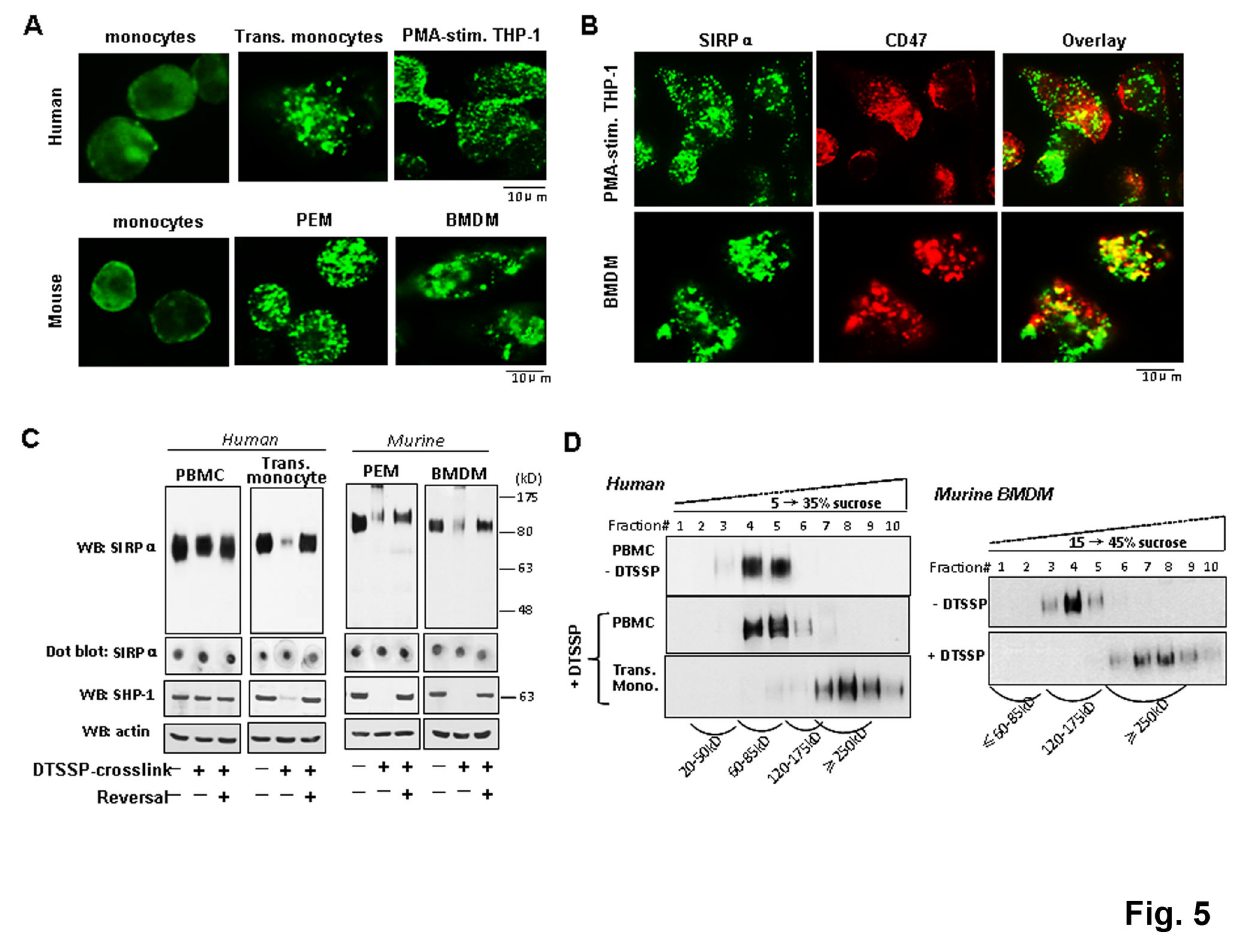
Figure 5. SIRPα on activated monocytes and macrophages forms clusters/complexes. A) Assessing SIRPα on naïve PBMC, transmigrated monocytes, PMA-induced THP-1 and murine macrophages by immunofluorescence staining using anti-SIRPα.ex and mAb P84, an antibody specific for the murine SIRPα extracellular domain. B) Staining of SIRPα and CD47 on PMA-stimulated THP-1 using anti-SIRPα.ex and mAb B6H12.2. C) DTSSP crosslinking to assess protein complexes consisting SIRPα. Different cells were treated with DTSSP (25°C, 30 min) prior to lysis in detergent-containing buffer. Lysate samples were analyzed by SDS- PAGE and WB under non-reducing or reducing (+DTT) conditions. The latter reverses the DTSSP crosslinking. Note: murine SIRPα appears to be 110-120 kD, larger than the human counterpart. Dot blot detection of SIRPα was performed by directly absorbing cell lysates onto nitrocellulose, prior to antibody blotting. D) Equilibrium centrifugation analysis of SIRPα complexes. After DTSSP crosslinking, cell lysates were applied to ultracentrifugation in sucrose density gradients. Following fractionation, SIRPα localization was analyzed by WB and compared to the sedimentation of a reference protein